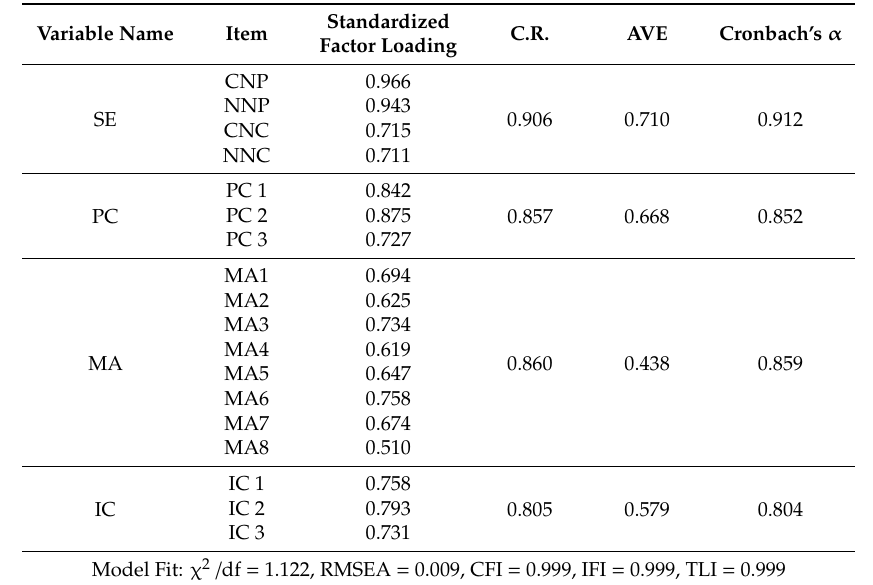
Table 3. Reliability and validity of the variables (N = 1548).